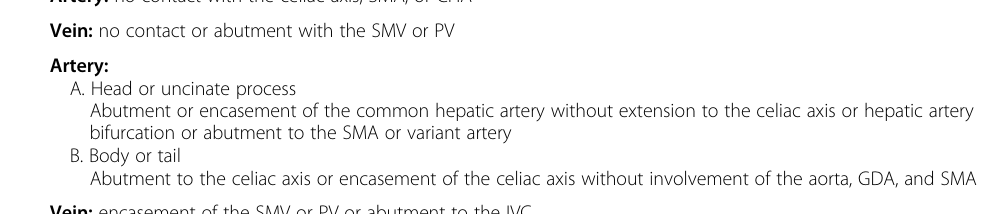
Table 1 NCCN Criteria for CT Resectability of Pancreatic Cancer